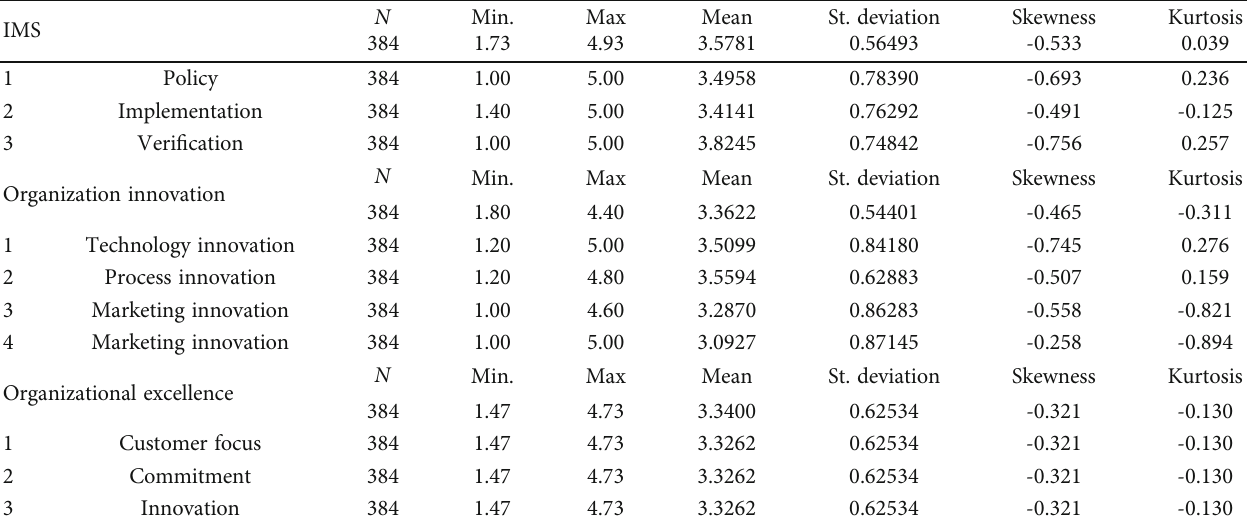
Table 5: Descriptive statistics of